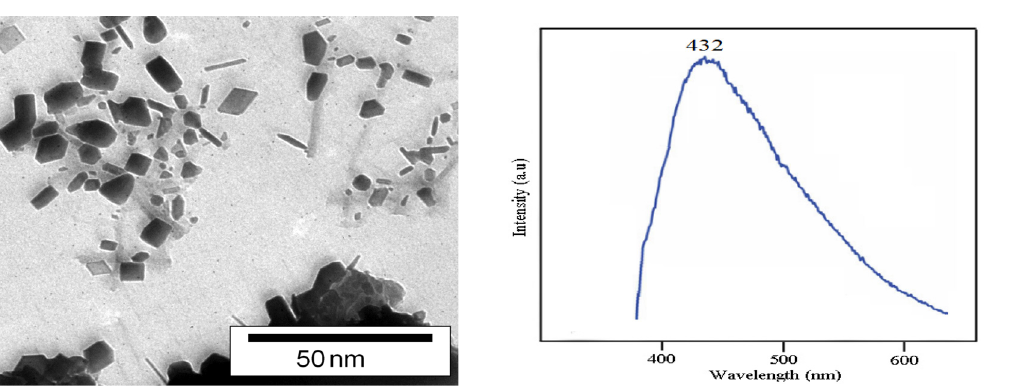
Fig. 4. TEM image sample no.2 of the synthesized Au nanoparticle.